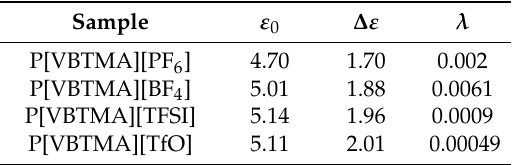
Table 1. Dielectric properties of PIL suspensions